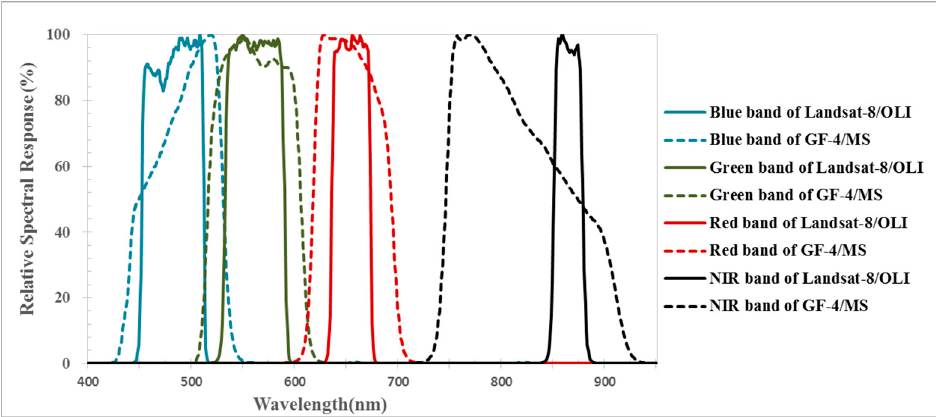
Figure 3. Difference curve in SPF for different spectral band of PMS and Operational Land Imager (OLI) (the SPF of PMS is published by CRESDA through its website [24]; and the SPF of OLI is published by NASA through its website [25]). Table 3. Spectral matching factor between GF-1/WFV and OLI. Band Blue Green Red NIR Spectral matching factor (a) 1.0653